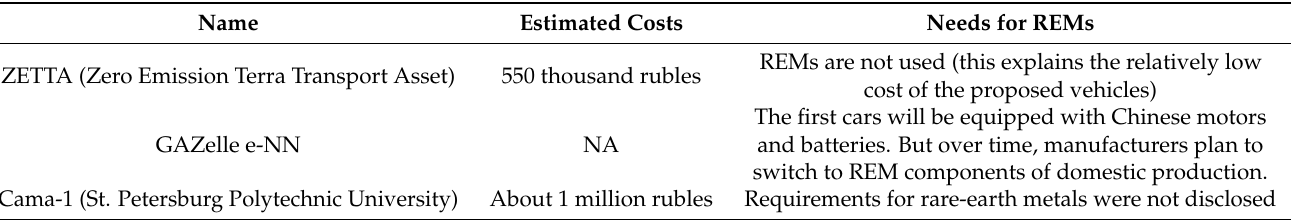
Table 4. Types of electric vehicles in Russia (preparations for launching production are in